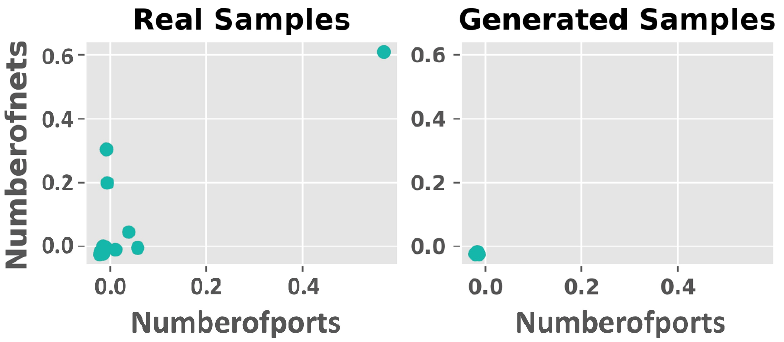
Figure 10. Presentation of how our worst-performing GAN-based model learned to synthesize new